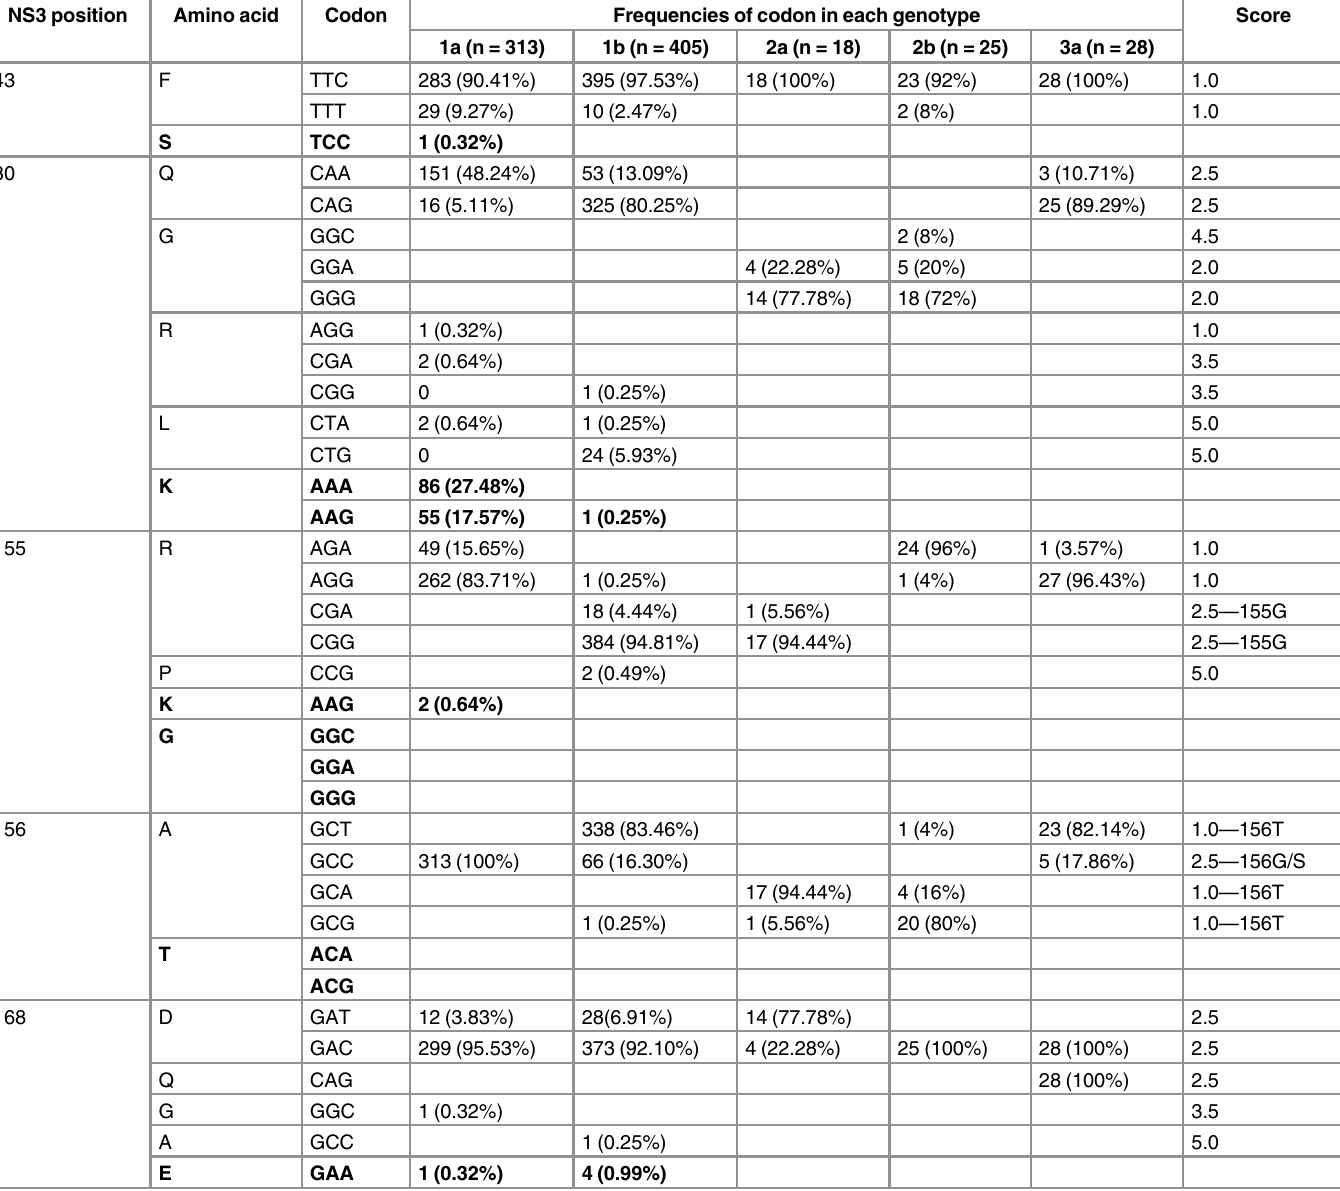
Table 1. Codon variability at HCV NS3 positions associated with major drug resistance to IP and its impact on the genetic barrier to drug resis- tance development in HCV genotypes 1 to 3. NS3 position Amino